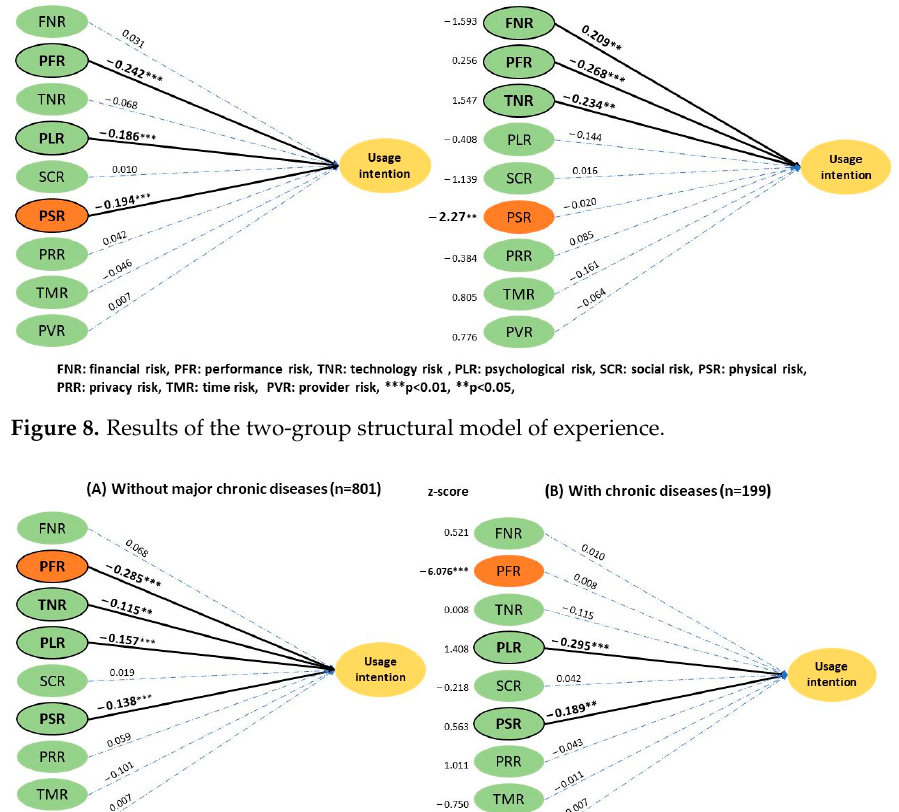
Figure 7. Results of the two-group structural model of monthly income.